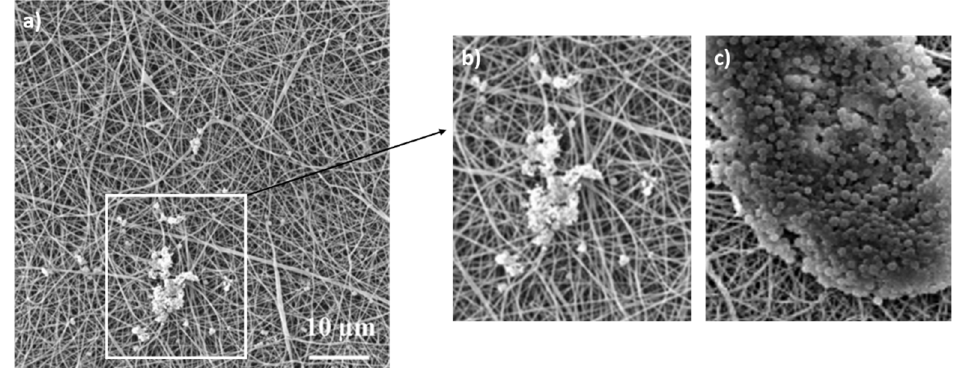
Figure 6. PA 12% 0.3 wt% AgNO 3 10 g/m 2 after the filtration of S. aureus CCM 4516 ( a , b ); silver is toxic for bacterial cells and damages their shape (magnification of 5000 ×); ( a ) overall view, ( b ) detail of damaged bacterial cells, ( c ) clusters of undamaged S. aureus CCM 4516 cells on nonfunctionalized PA for a comparison with the silver one.